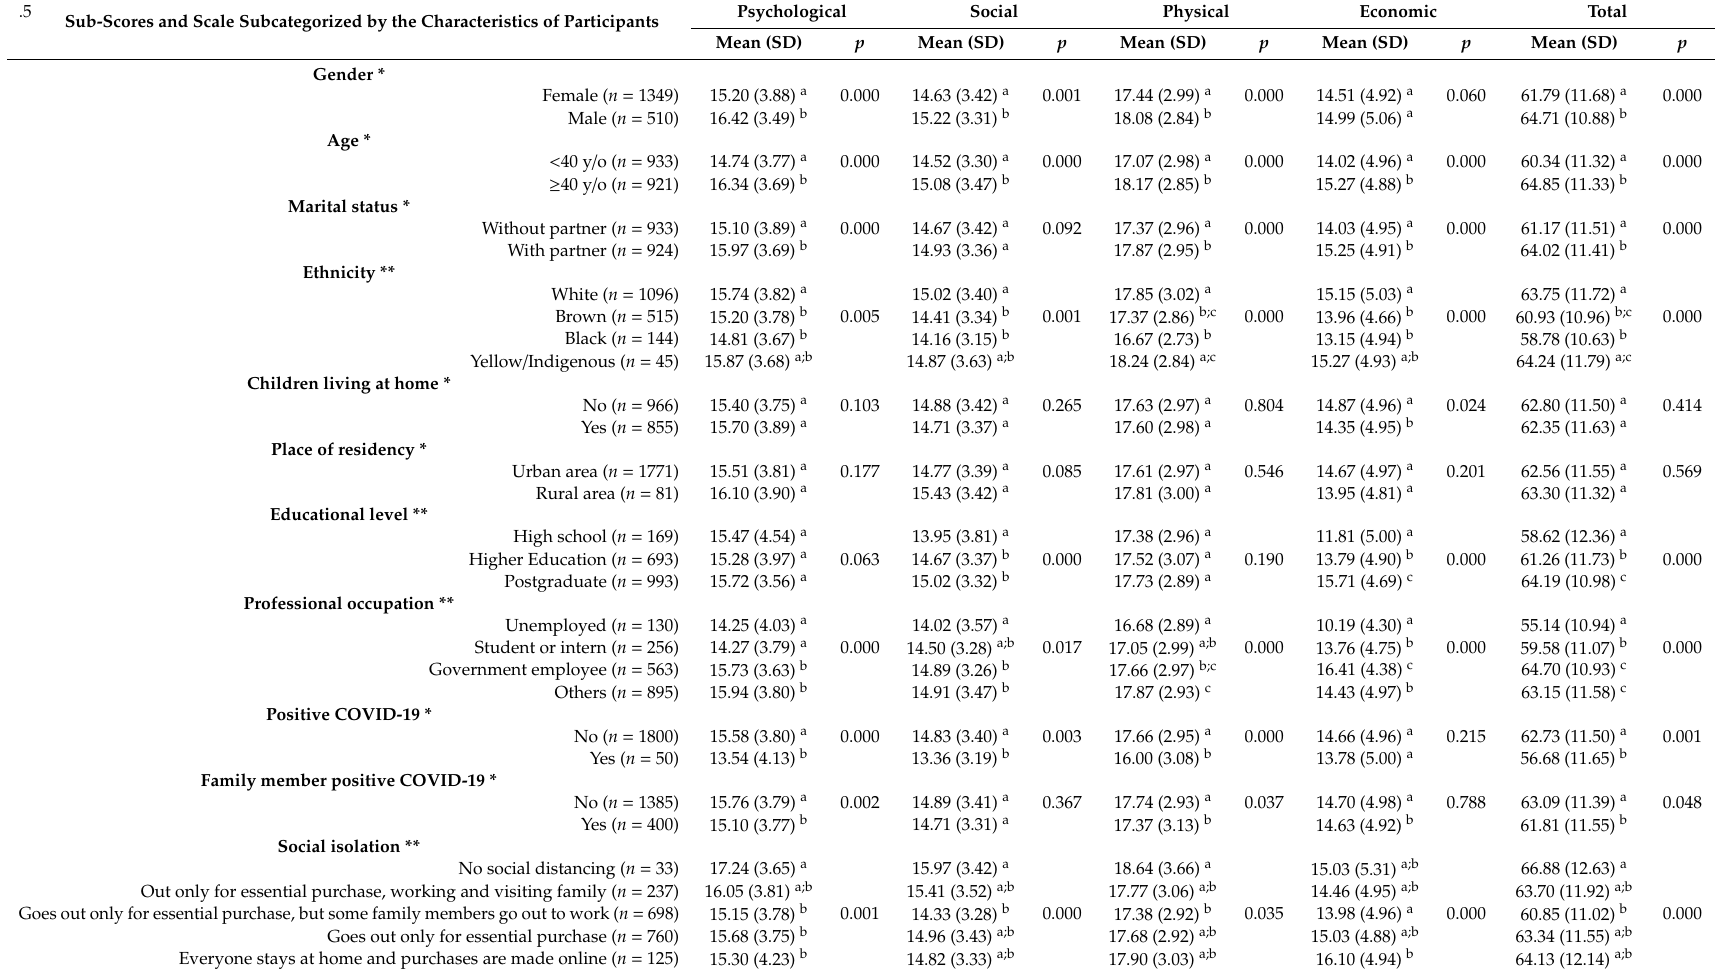
Table 1. Quality of life by socioeconomic and demographic variables of Brazilian individuals during the pandemic period.